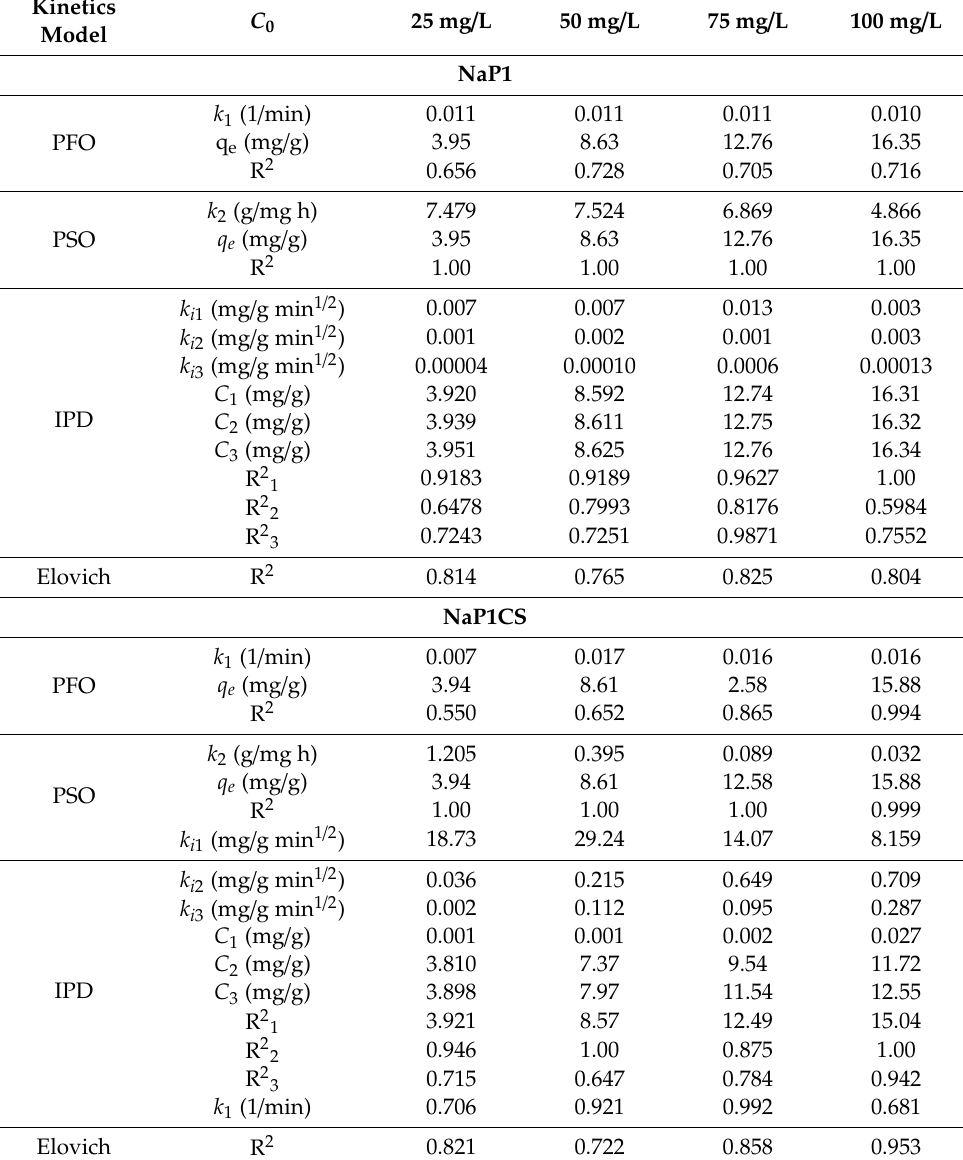
Table 5. Comparison of kinetic parameters for Cu(II) on NaP1 and